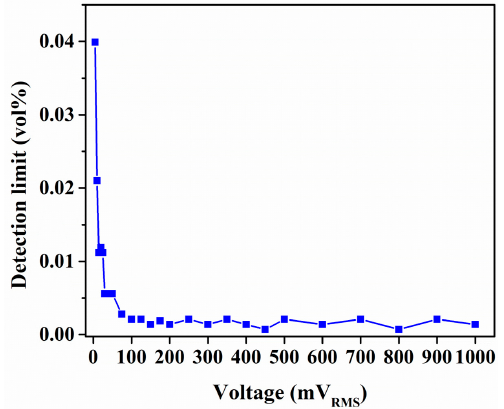
Figure 10. Tunability of the limit of detection by changing the drive voltage in the case of IDE-based capacitive acetone sensor.